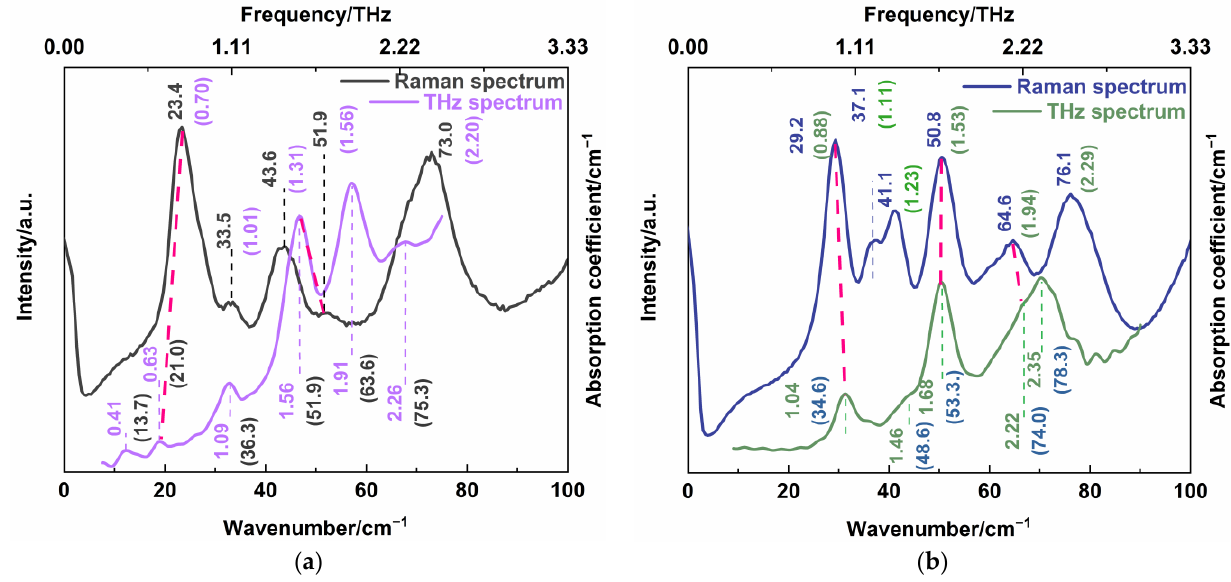
Figure 8. Comparison of THz absorption spectra and low-wavenumber Raman spectra of ( a ) CBZ- NIC and ( b ) CBZ-SAC co-crystals.